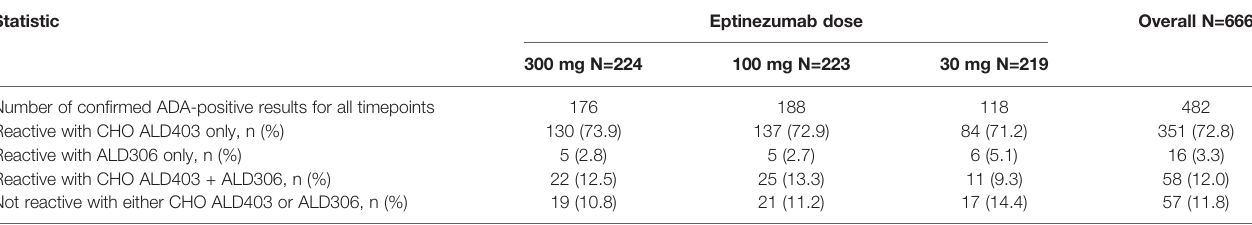
TABLE 3 | Speci fi city of ADA signals detected at all timepoints in PROMISE 1. Statistic